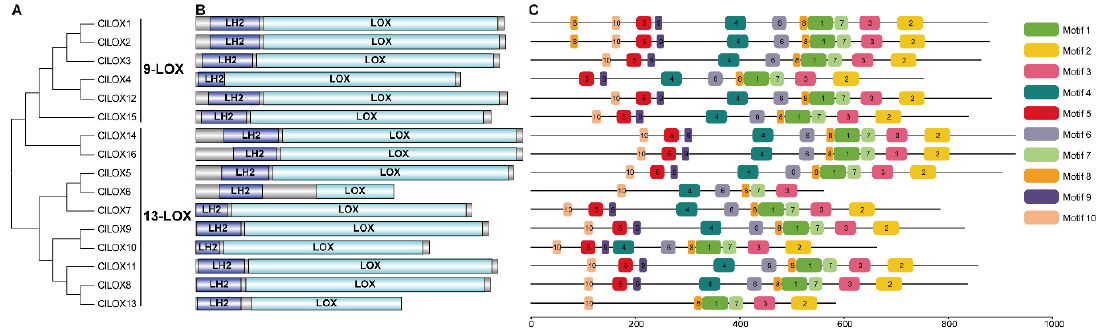
Figure 2. Phylogenetic relationships ( A ), conserved domains ( B ) and motif compositions ( C ) of ClLOX proteins.